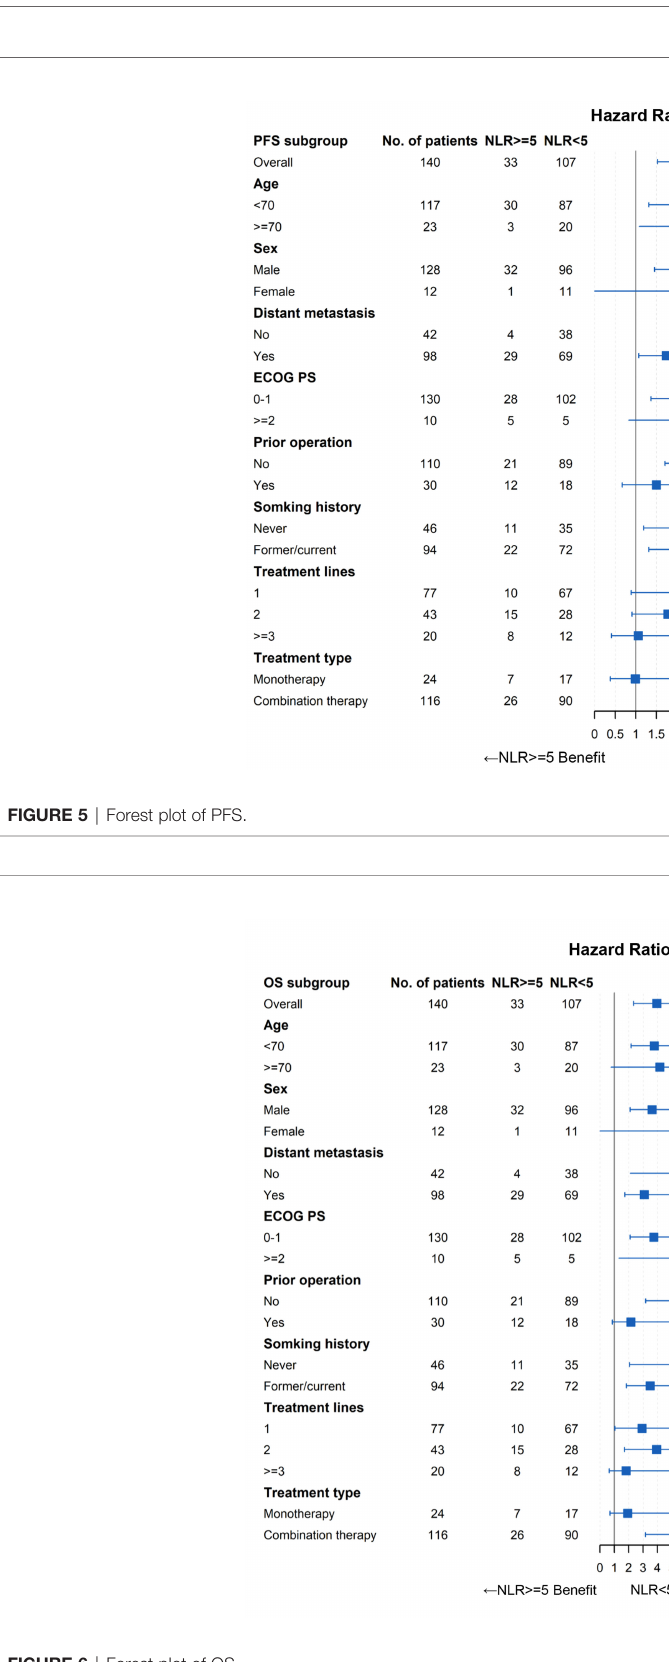
FIGURE 6 | Forest plot of